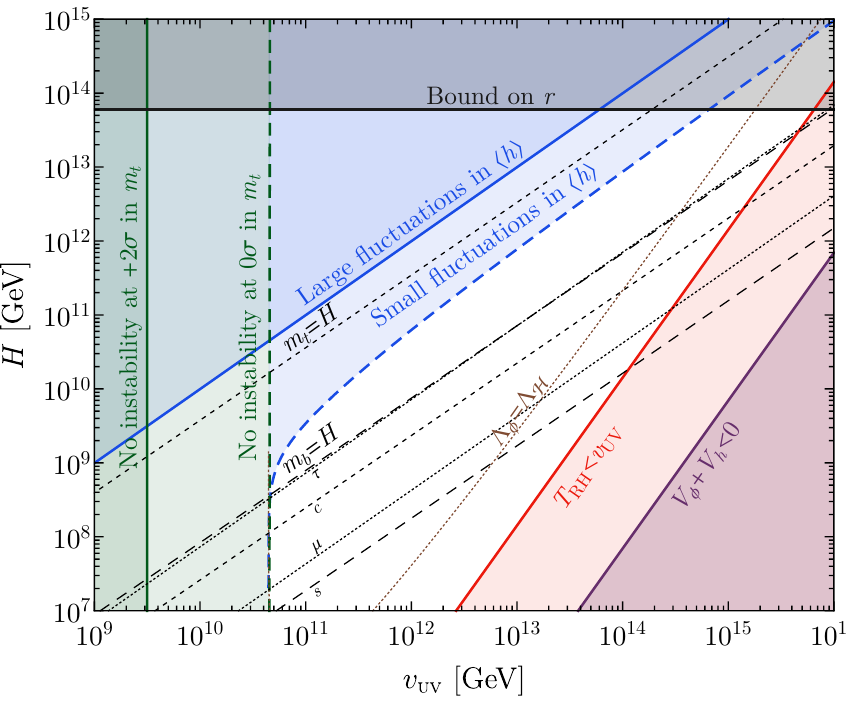
Figure 3 . Viable parameter space in the plane ( v uv ; H ). The shaded regions are excluded due to following constraints, listed also in the text: H allowed by the bound on r (gray), negligible quantum (cid:13)uctuations at h = v uv (blue), Higgs quartic turning negative within the SM (green), high enough T rh to rescue the Higgs (red), Higgs energy density smaller than the in(cid:13)aton one (purple). The thin black lines show where m f = H for the SM fermions. The thin dotted brown line corresponds to the case in which the energy scale (cid:3) (cid:30) of the in(cid:13)aton is equal to (cid:3) H